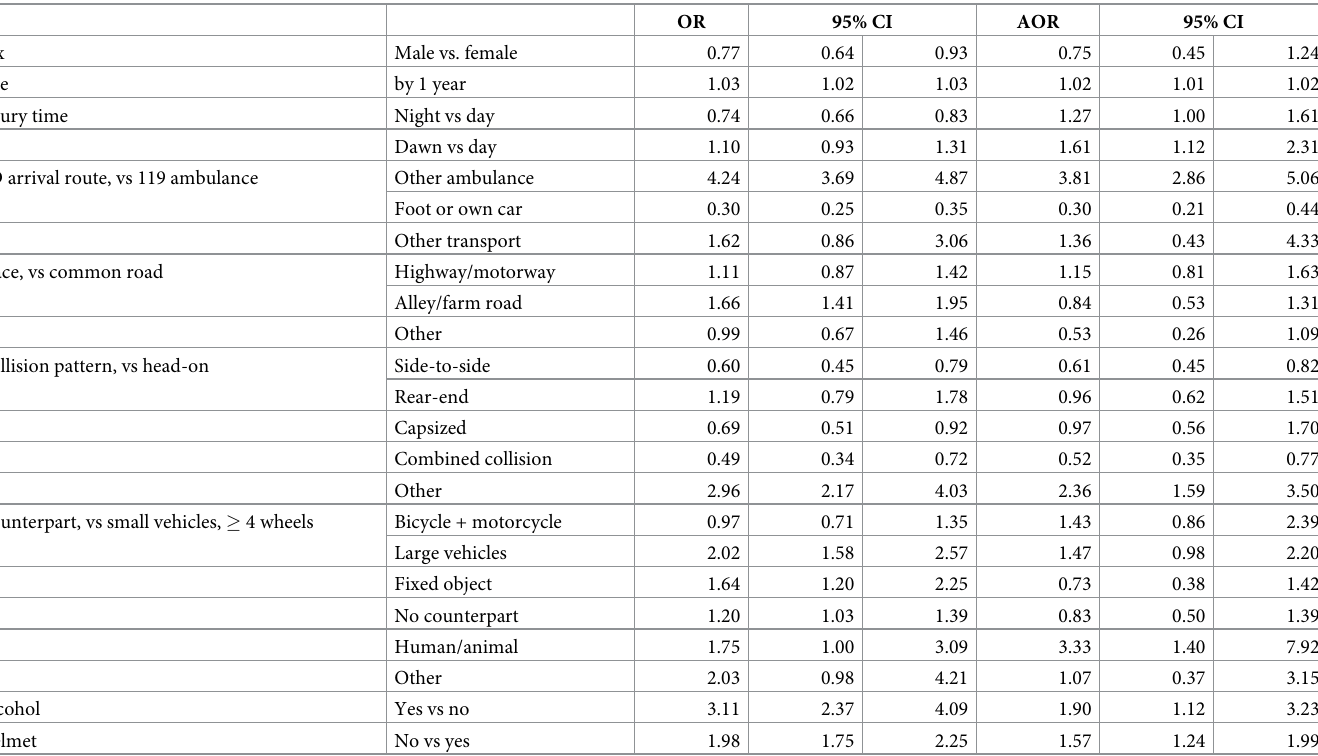
Table 3. Adjusted odds ratios and confidence intervals of injury characteristics to severity among occupational motorcycle injury